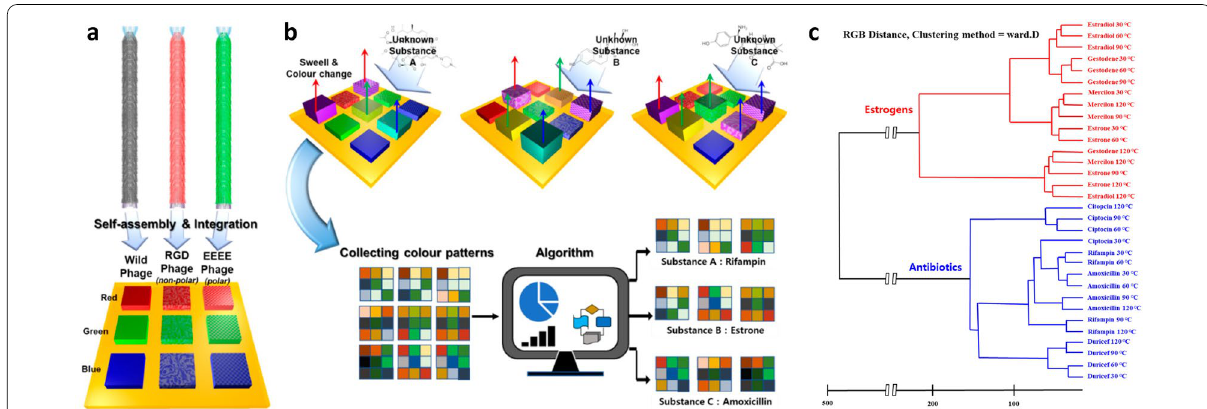
Fig. 7 Multi‑array colourimetric sensor based on the genetically engineered M13 bacteriophages. a Schematic diagram of colourimetric sensor array using genetically engineered M13 bacteriophages. b Analytic algorithm to classify an unknown substance. c Hierarchical cluster analysis dendrogram for eight types of medical chemicals using the colour distance (Ward.D linkage method) ( a – c Adapted from Ref.